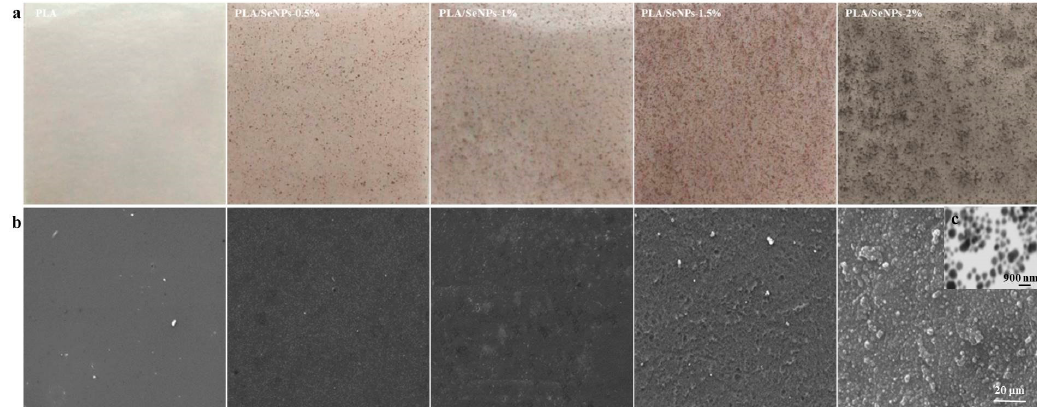
Figure 2. Physical characterization of PLA and PLA/SeMPs films. ( a ): Pictures of PLA and composite films with different concentrations; ( b ): scanning electron microscopy (SEM) images of the film samples corresponding to five films; ( c ): transmission electron microscopy TEM images of PLA/SeMPs-2% films.